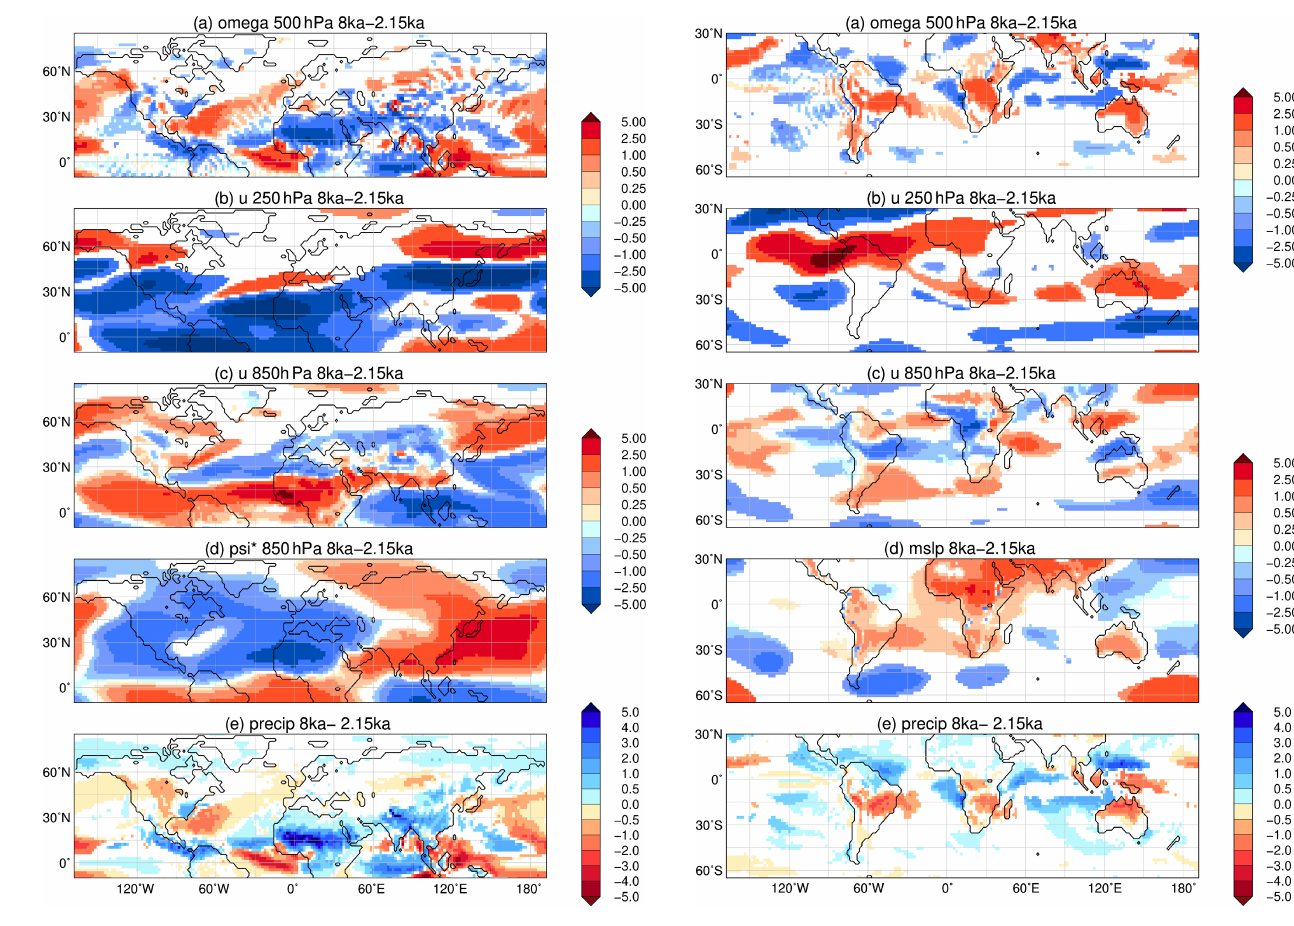
Figure 9. Simulated difference in December to February (DJF, aus- tral summer) mean climate in the model for the time slice at 8ka compared to 2.15ka, i.e. (a) vertical velocity (omega) in 500hPa (10 − 2 ms − 1 ) with blue colour showing increased uplift during 8ka; (b) upper-tropospheric zonal wind ( u ) in 250hPa (ms − 1 ) with blue colours indicating enhanced easterly wind; (c) low-level zonal flow ( u ) in 850hPa (ms − 1 ); (d) mean sea level pressure (hPa) with low- pressure anomaly given in blue colours; and (e) mean seasonal pre- cipitation (mmd − 1 ) with blue colours showing enhanced precipita- tion during 8ka. Only significant changes are shown ( t test, 99% confidence